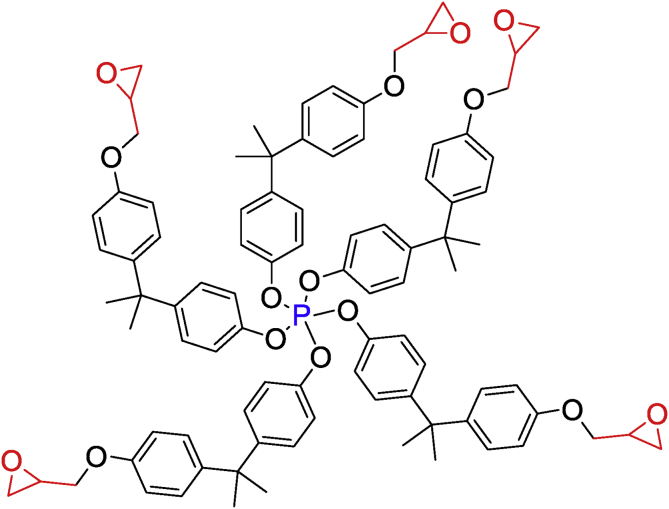
Structure of PGEPBAP [41].